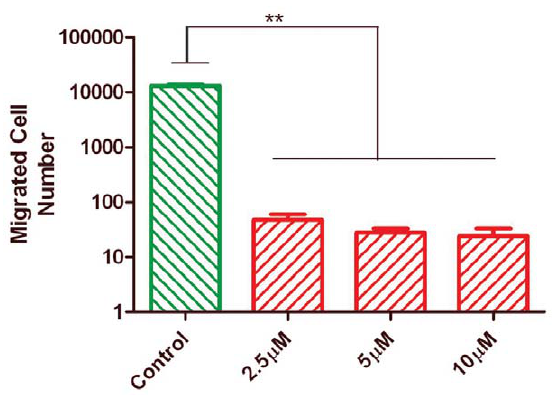
Figure 1. AMD3465 affects the invitro invasiveness of 4T1 cells. 4T1 cells in serum-free medium were seeded in matrigel transwells and allowed to migrate 48 h towards compartments with medium containing 10% FBS without (PBS) and with AMD3465 (2.5, 5, and 10 m M) present. All of the samples were conducted in triplicate and expressed as the mean value 6 SD (error bars, **p ,